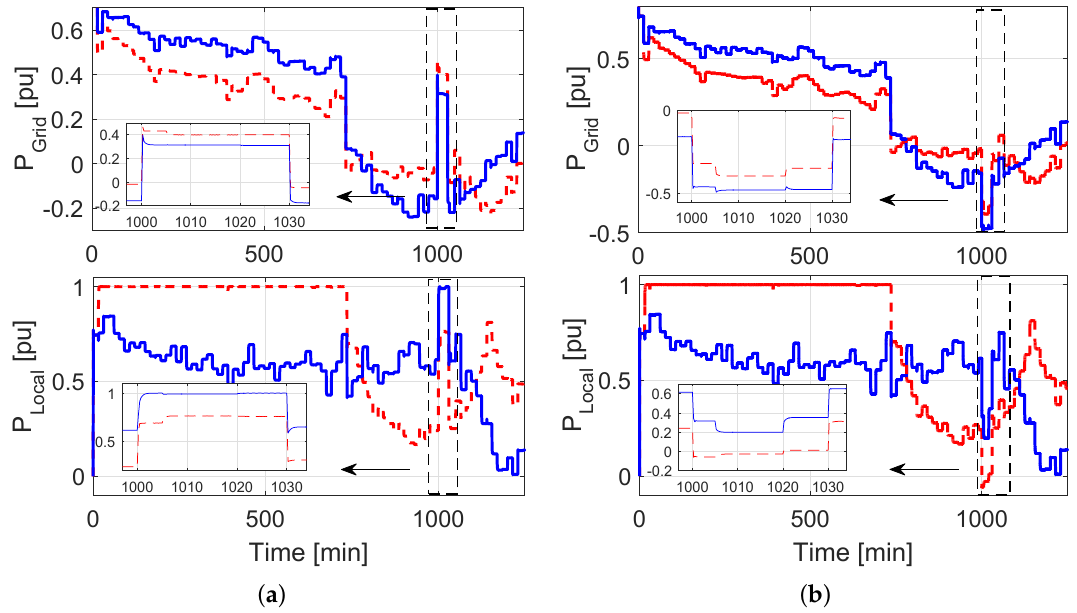
Figure 2. Result obtained from the simulations with both the proposed Energy Management System (solid blue line) and the EMS with perfect predictions of Equation (1) (dashed red line). ( a ) Power imported from the grid (top) and locally generated (bottom) under a sudden disconnection of the wind turbine at 1000 min; ( b ) Power imported from the grid (top) and locally generated (bottom) under a load impact at 1000